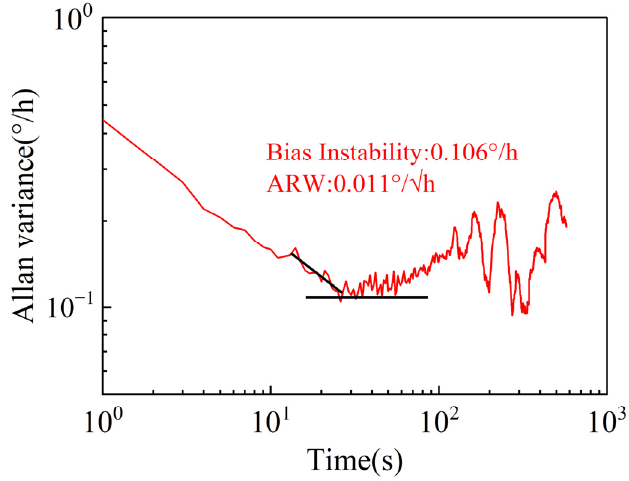
Figure 9. Allan variance curve.